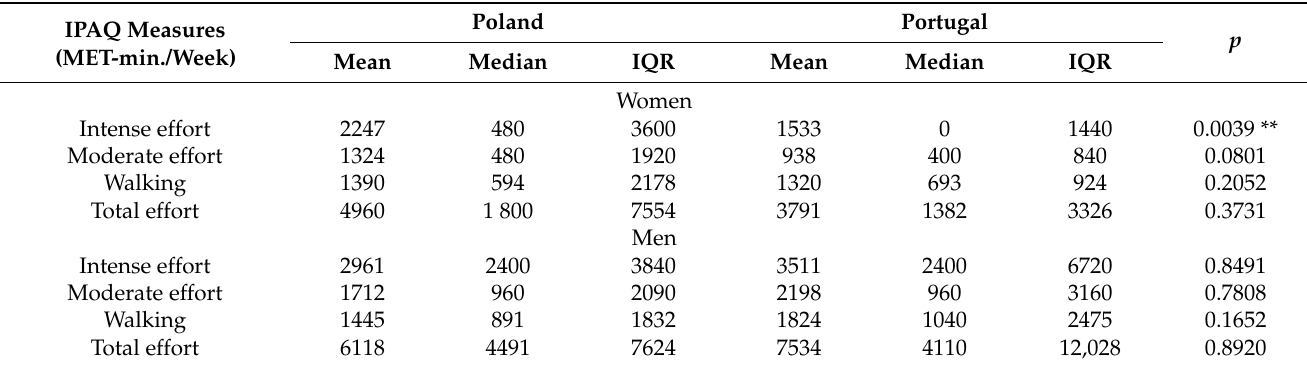
Table 5. Summary of IPAQ specific